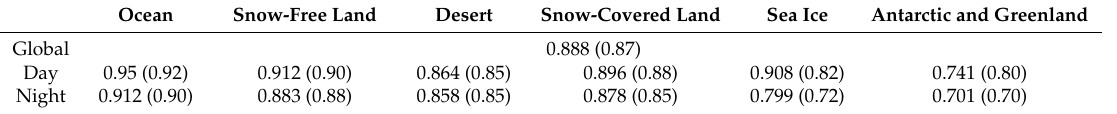
Table 3. S-NPP VIIRS cloud products performance (accuracy: magnitude of the mean measurement errors; precision: the standard deviation of the measurement errors